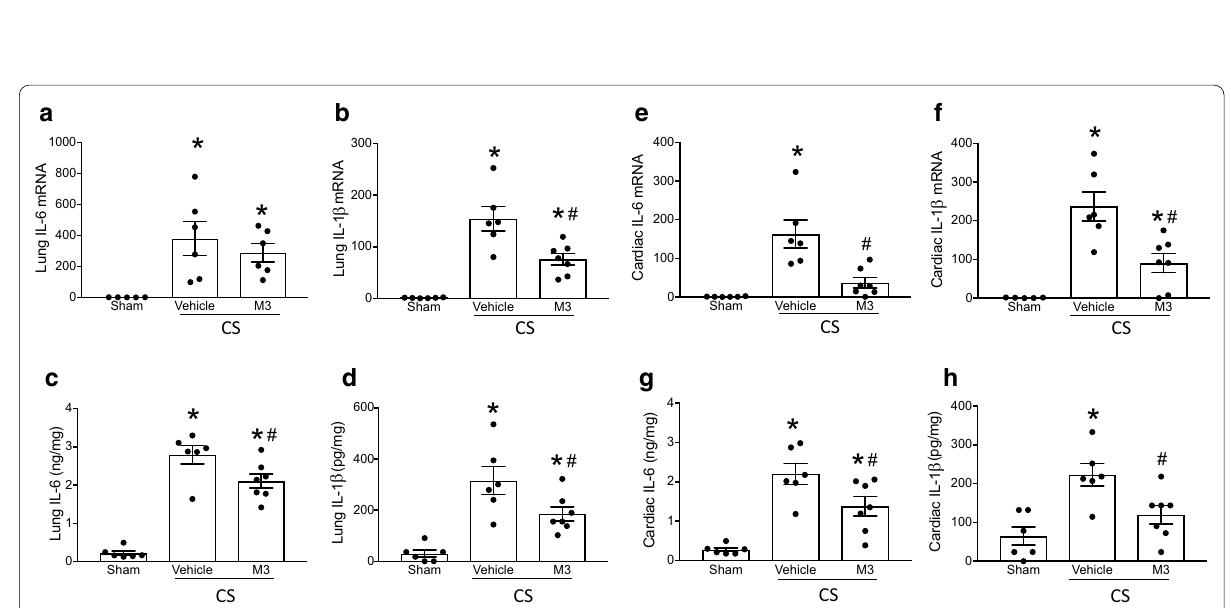
Fig. 3 M3 improves pulmonary and cardiac inflammation. 16 h after cecal slurry sepsis induction, mRNA and protein levels of proinflammatory cytokines were measured by RT‑PCR and ELISA. Lung levels of IL‑6 and IL‑1β ( a , b ) mRNA and ( c , d ) protein were increased by sepsis and reduced in M3 treated pups. Analogously, cardiac IL‑6 and IL‑1β ( e , f ) mRNA and ( g , h ) protein were elevated in vehicle treated pups as opposed to M3 treated septic neonates. Data are expressed as means SE (sham 6, vehicle 6, and M3 7 pups). Multiple groups were compared by one‑way ANOVA ± = = = and Tukey method (*p < 0.05 vs. sham; # p < 0.05 vs.